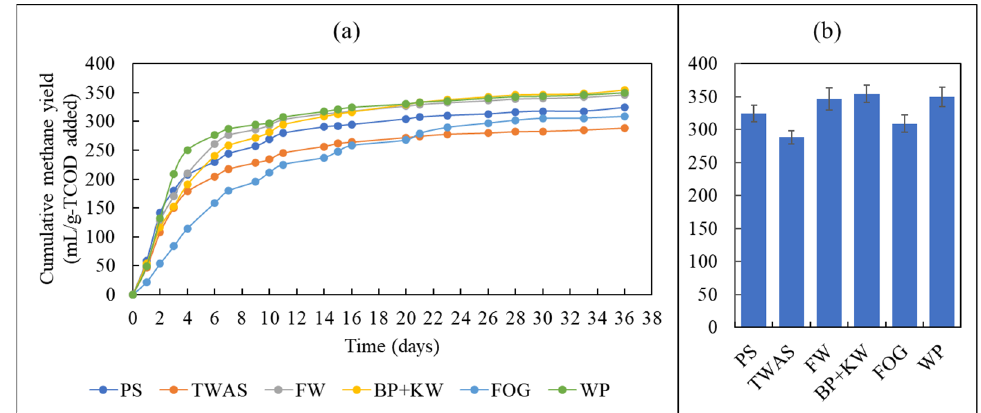
Figure 6. Methane yield per mass of TCOD substrate added for all the different substrates. ( a ) Cumulative methane yield, ( b ) maximum methane yield.